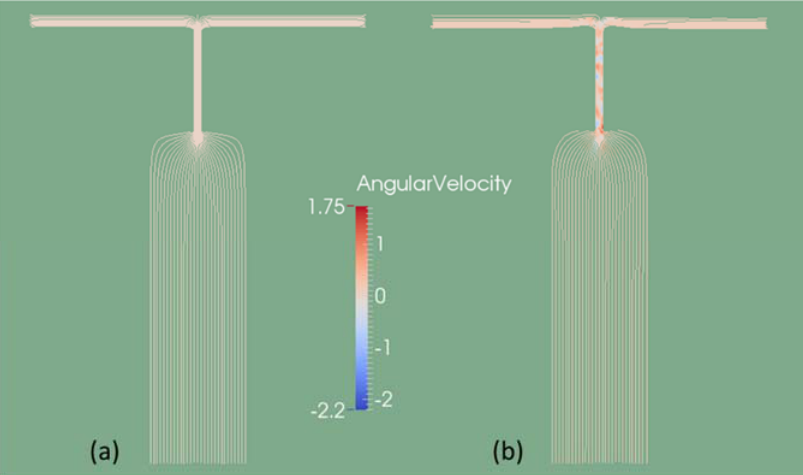
Figure 3. Streamlines and angular velocity in the Newtonian fluid case ( a ) and viscoelastic fluid case ( b ) under constant driving pressure at both inlets.